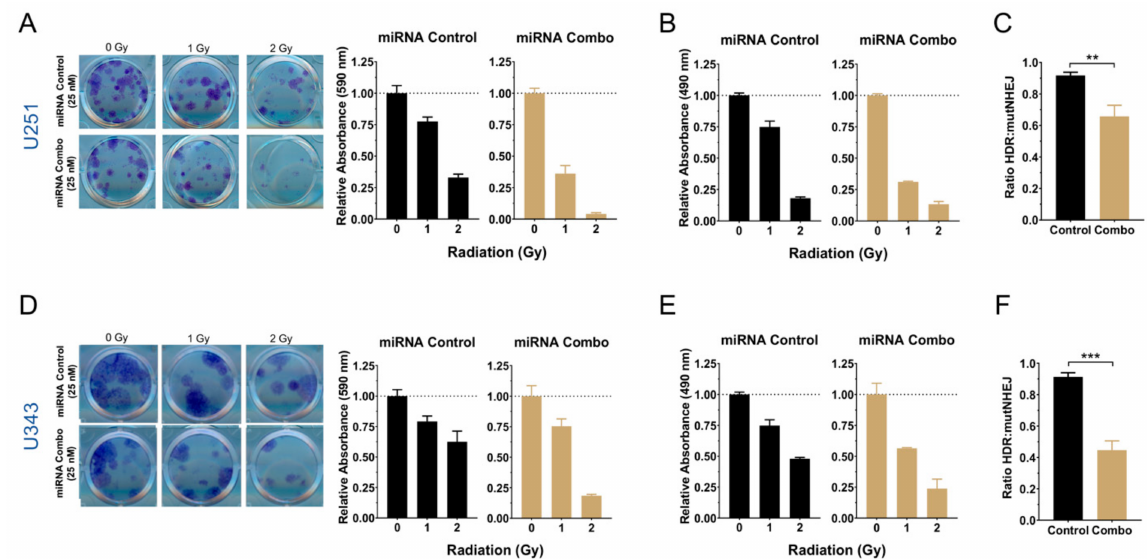
Figure 7. miRNA combo glioblastoma cells. ( A , D ) Left: representative aspects of U251 and U343 cells transfected with control or miRNA combination (miR-124, -128, and -137) clonogenic ability following exposure to ionizing radiation; right, quantification of clonogenic assay results. ( B , E ) Viability of U251 and U343 cells transfected with control or miRNA combination 48 h after exposure to ionizing radiation. ( C , F ) Results of traffic light reporter assays displaying ratios of homologous recombination to mutant NHEJ of U251 and U343 cells transfected with control or miRNA combination 48 h after transfection with the I-SceI plasmid. Student’s t -test: ** p < 0.01; *** p <